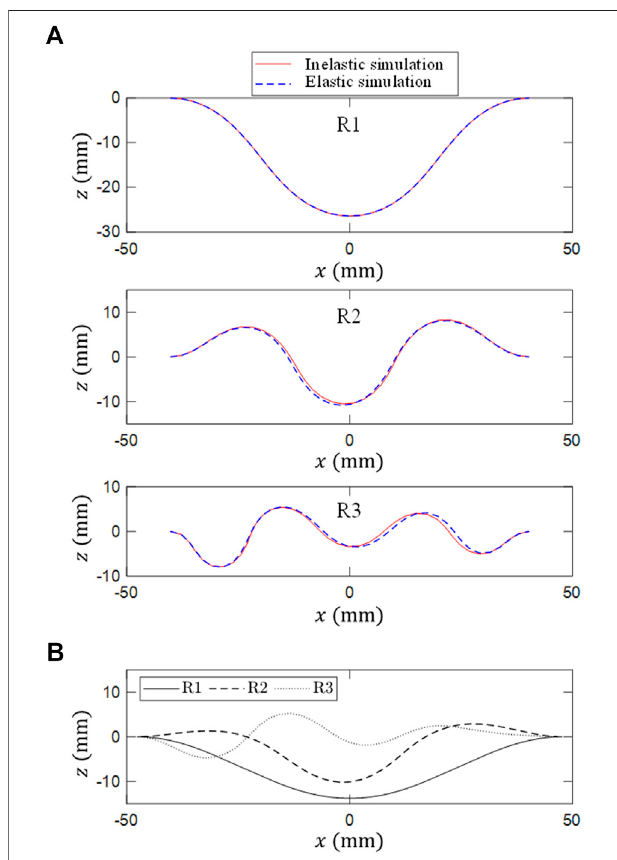
FIGURE 13 | (A) Simulation of wrinkling under longitudinal compression of woven reinforcements of stiffness R1, R2 and R3, (B) Deformed shapes of the reinforcements after